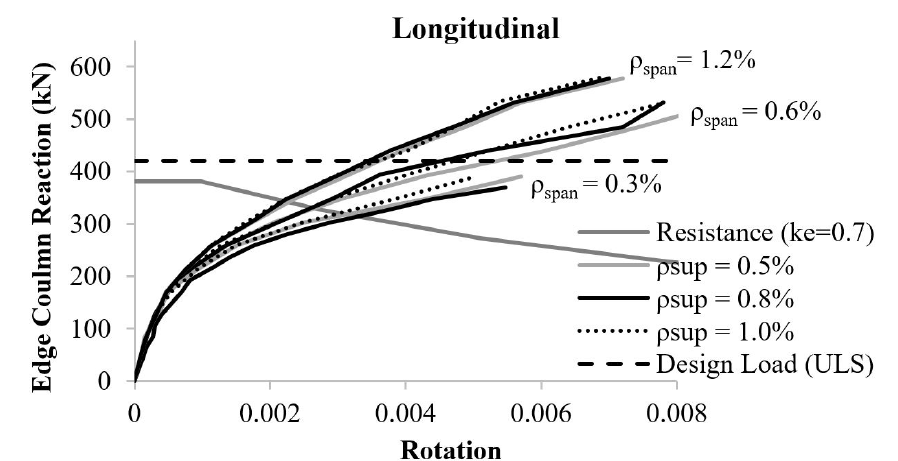
Figure 11. Longitudinal rotation of the subassembly’s edge column from the parametric